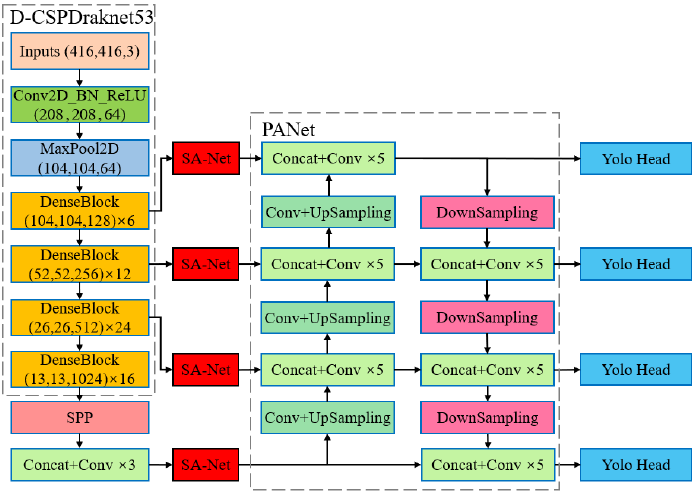
Figure 8. DSMH-YOLOv4 structure diagram.